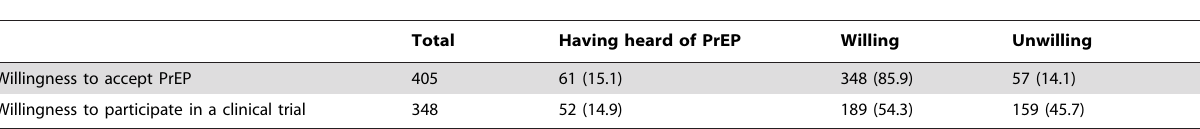
Table 2. Willingness to accept PrEP or participate in a clinical trial (N,